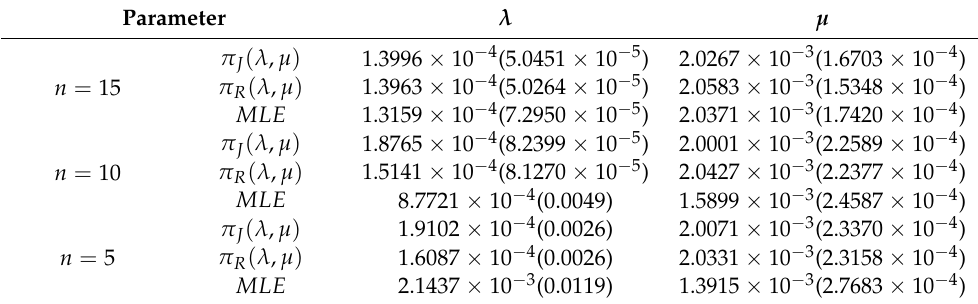
Table 6. Point estimators and WCIs (within bracket) of parameters based on different